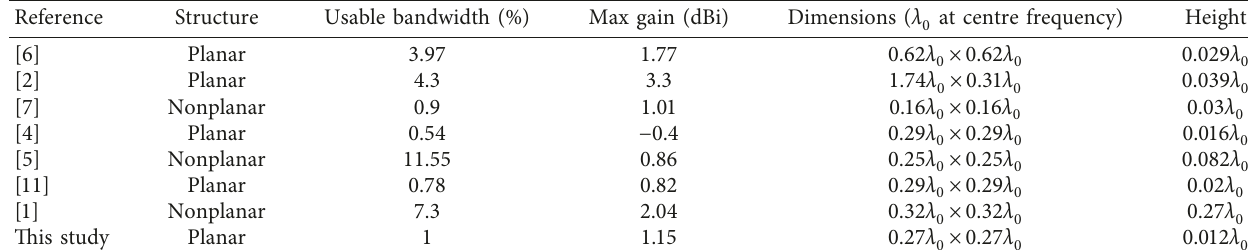
Figure 11: RHCP and LHCP patterns of fr � 2.49175GHz; (a) normalized 2D pattern at xoy plane; (b) normalized 2D pattern at xoz plane. Table 1: Comparison of reference and the proposed